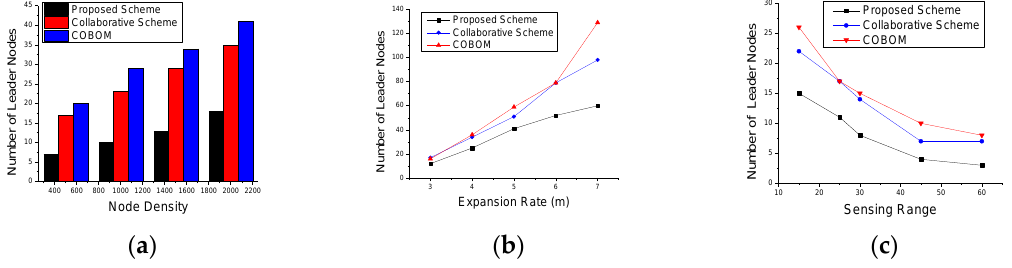
Figure 9. Number of leader nodes with different ( a ) node densities; ( b ) expansion rates; and ( c ) sensing ranges.